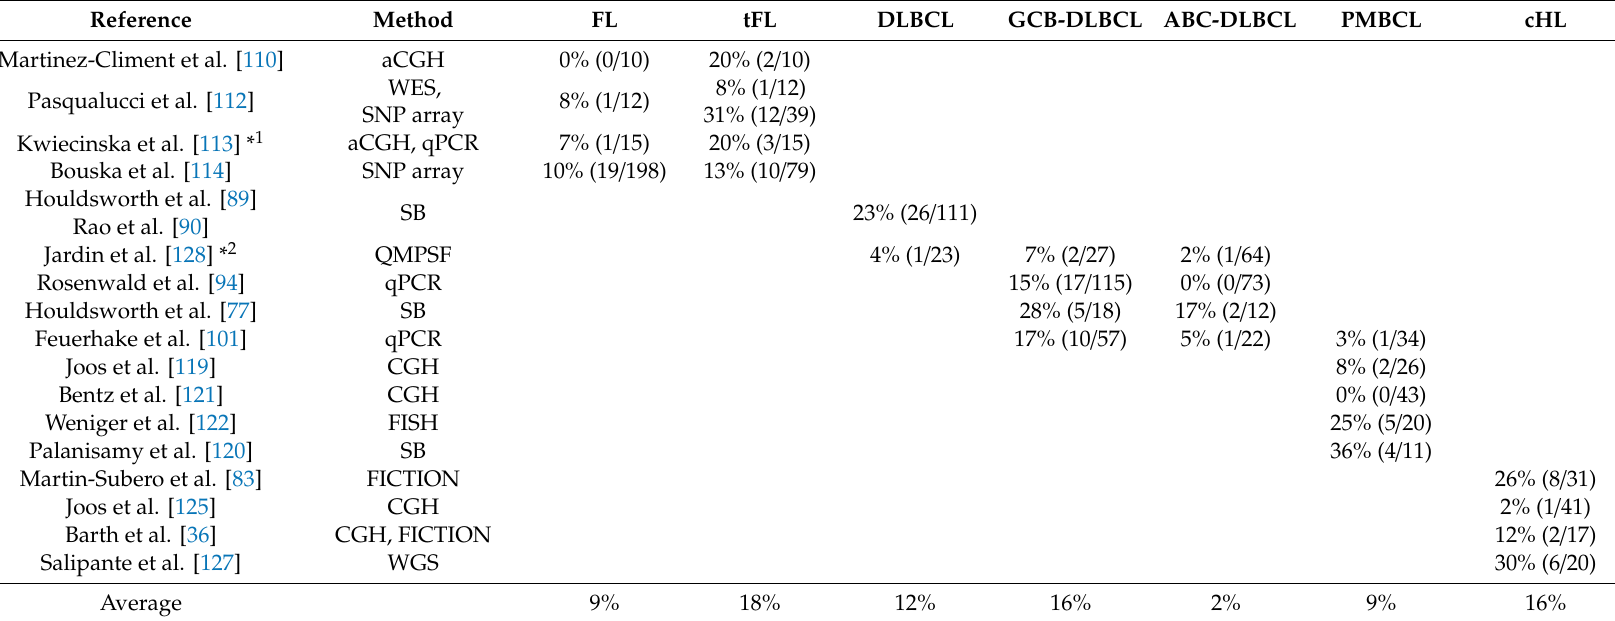
Table 2. Frequency of REL gene locus amplifications in human B cell lymphoma subtypes. The frequencies of amplifications are displayed. Studies summarized in Table 1 were included in this table if amplifications were defined as a REL copy number of ≥ 4 copies or REL gene ratio of ≥ 2. In parenthesis, the fraction of the total number of investigated patients is given. The average percentage of REL amplification per subtype (bold, last row) was calculated using the sum of total reported patient numbers, the average for DLBCL includes data from both GCB- and ABC-DLBCL subgroups. * 1 aCGH results distinguishing gains and amplifications only provided for 15 paired FL / tFL samples. Part of the total patient panel was additionally analyzed by qPCR. * 2 Jardin et al. [128] did not distinguish gains / amplifications but provided gene ratios for all samples. Numbers presented here are based on a REL gene ratio of ≥ 2 representing amplifications. For additional information on studies and provided numbers as well as method abbreviations see legend of Table